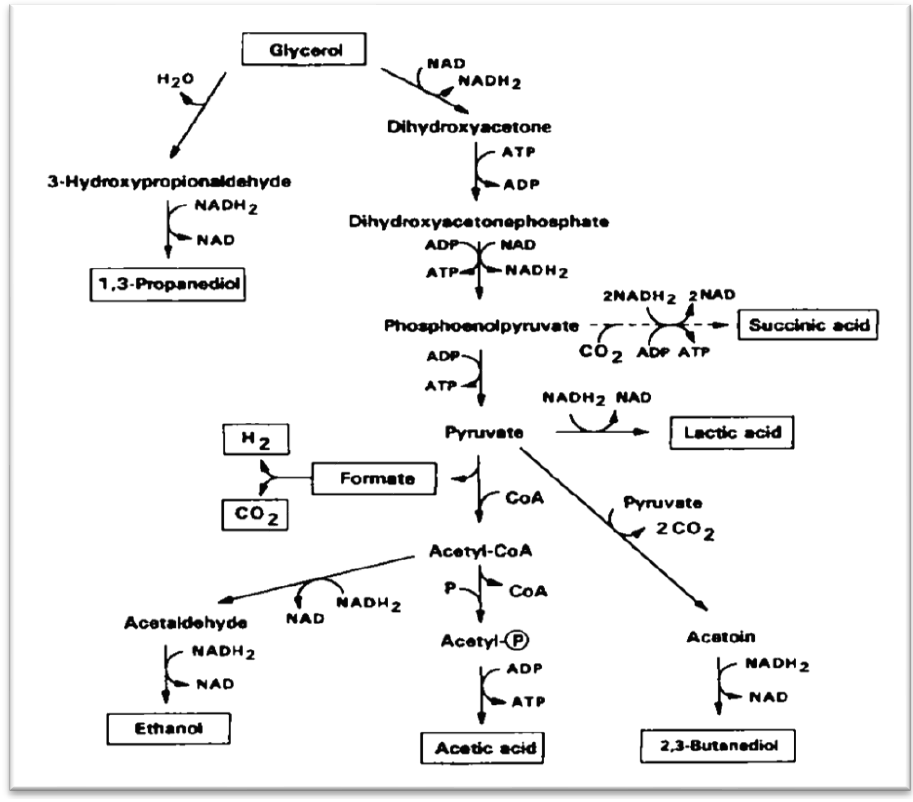
Figure 2. Glucose metabolic pathway in L. reuteri [13].